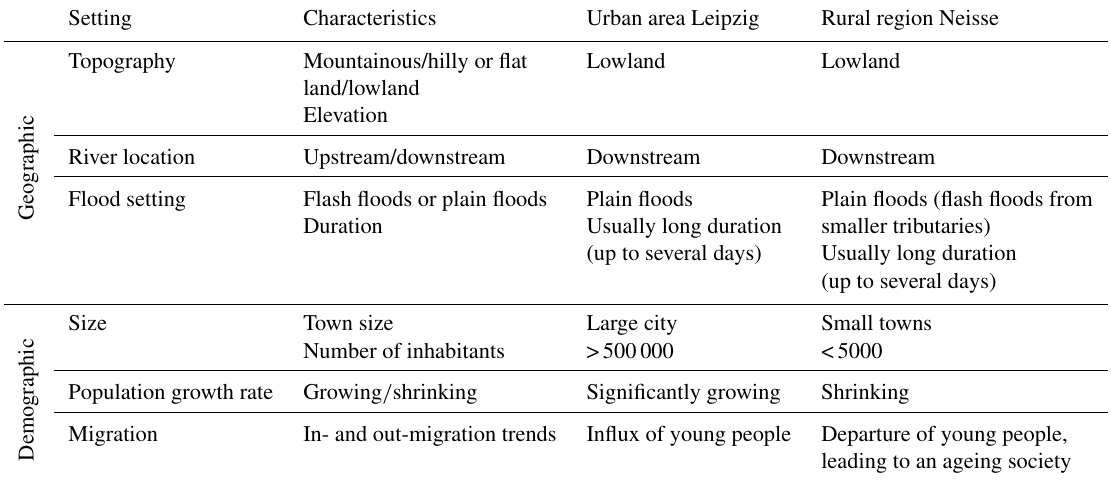
tion measure fulfilment curve (Fig. 4b, black dashed